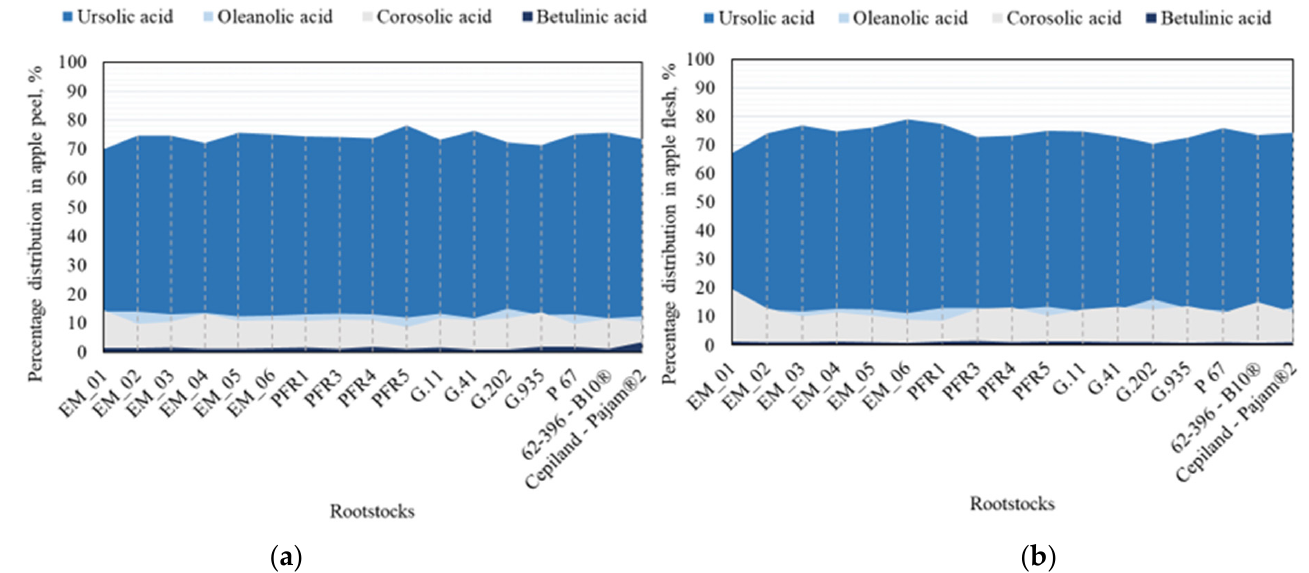
Figure 6. Percentage distribution of individual triterpenes: ( a ) Percentage distribution of triterpenes in apple peel samples; ( b ) percentage distribution of triterpenes in apple flesh samples.